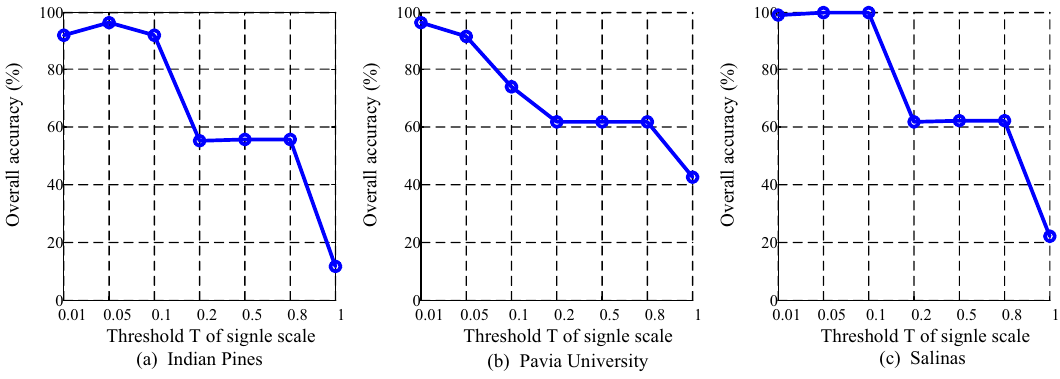
Figure 8. Overall accuracy of single scale low rank representation.